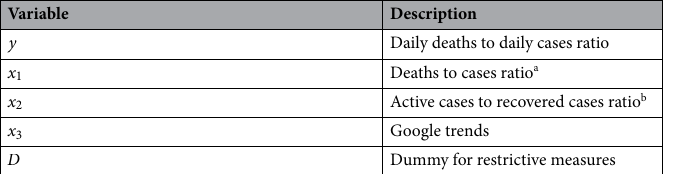
Table 2. Descriptions of the dependent and independent variables for the daily deaths/daily cases model. a Refers to total deaths and total cases. b Refers to total active cases and total recovered